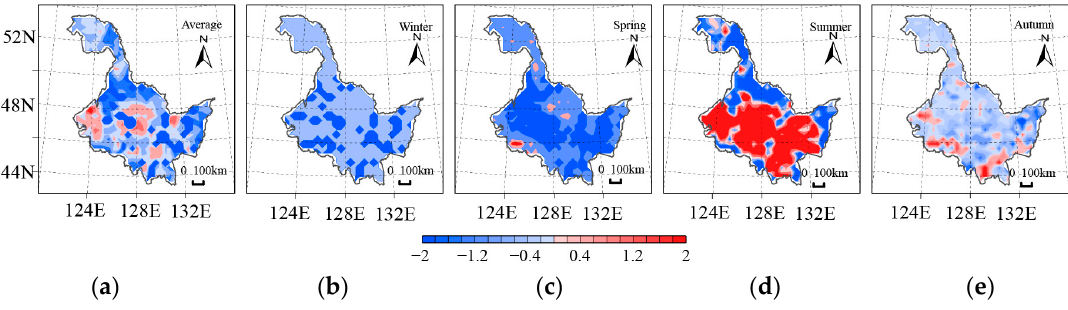
Figure 10. Maps to show the spatial distribution of surface net flux changes caused by the conversion of forests to cropland. ( a ) Annual average; ( b )Winter; ( c ) Spring; ( d ) Summer; ( e ) Autumn. Table 3. Mean changes in surface solar radiation and the heat flux budgets of grid cells containing forests converted into cropland (i.e., sensitive simulations minus the control).